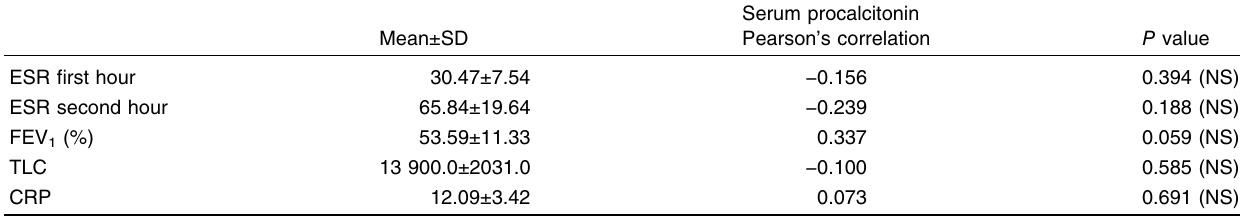
Table 22 Correlation between serum procalcitonin and different studied parameters in the bacterial group ( N = 32)